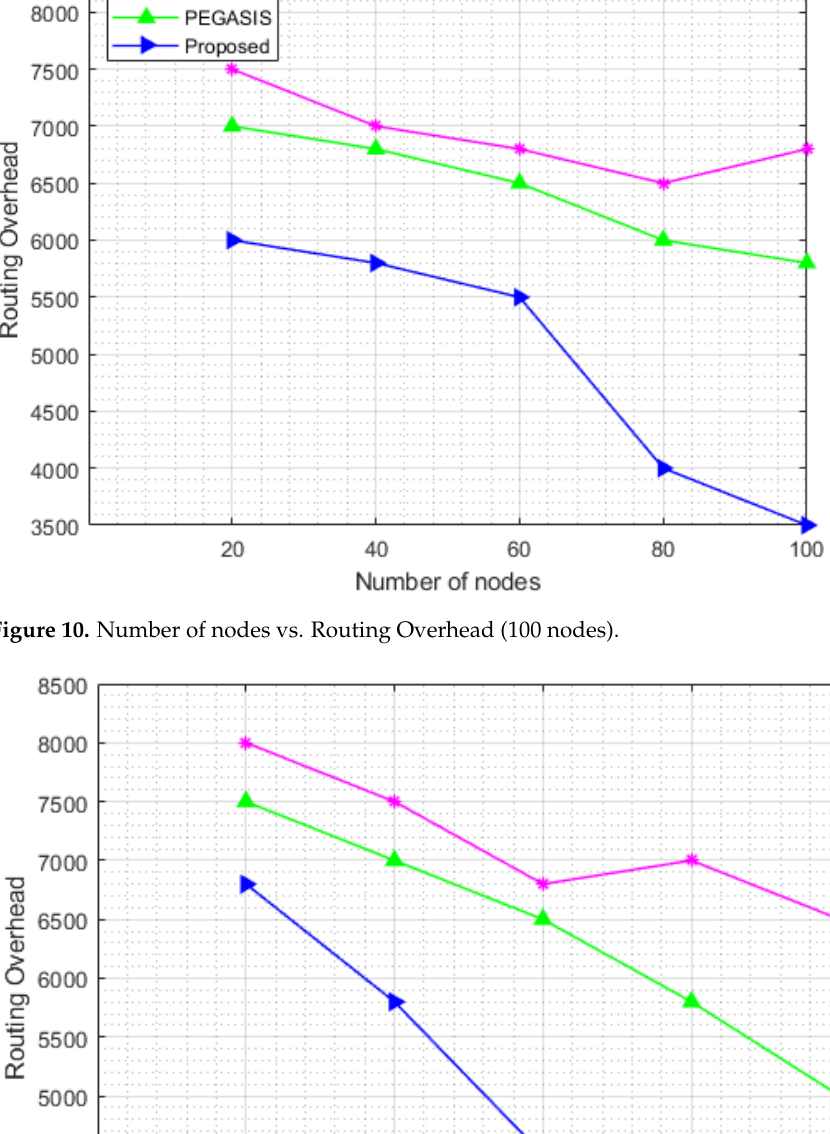
Figure 12. Number of nodes vs. packet delivery ratio (100 nodes).